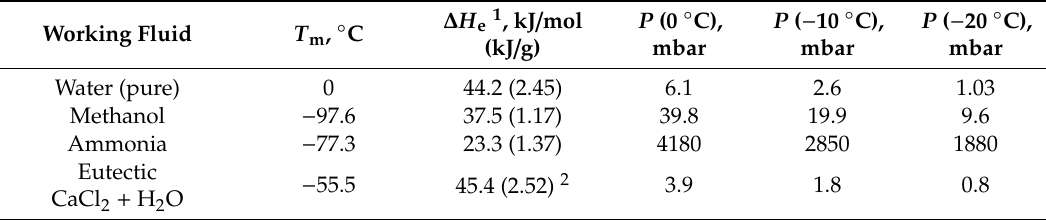
Table 1. Thermodynamic parameters of various working fluids.